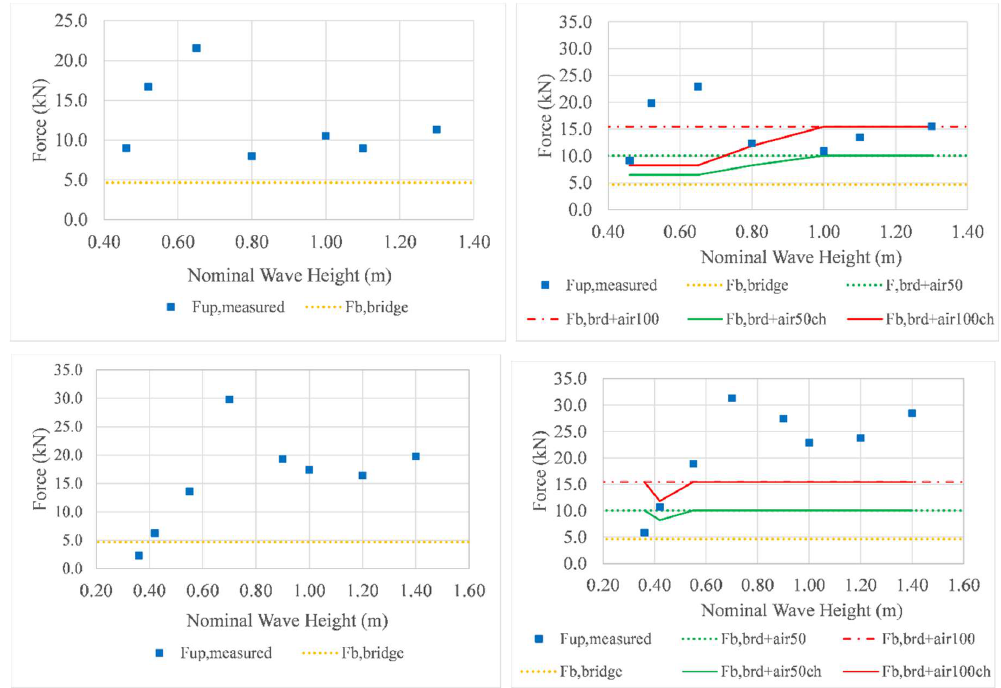
Figure 16. Calculated buoyancy and recorded maximum uplift forces for the deck with cross-frames ( left ) and the one with solid diaphragms ( right ), for d = 1.90 m (t op ) and d = 2.00 m ( bottom )